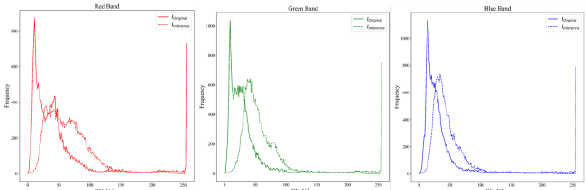
Figure 17 . Comparison of histograms between ground truth (up sampled S2) and model generated image of a selected test data tile from EXP2 (correspond to image tile used in Figure 13 (b) and